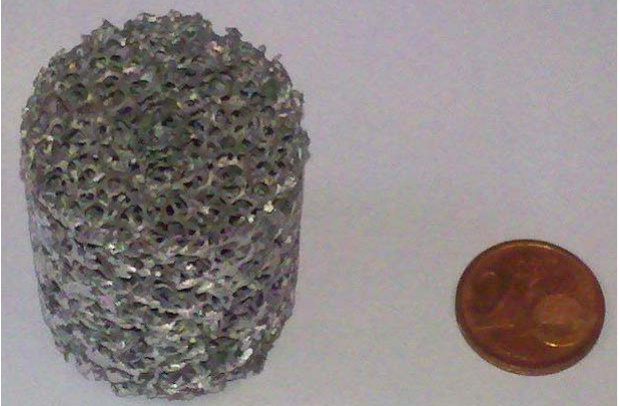
Figure 10. Aluminum foam (10 ppi). The catalyst particles (e.g., Pd/ZrO of 1.2 mm–1.4 mm were interspersed into the pores of the aluminum